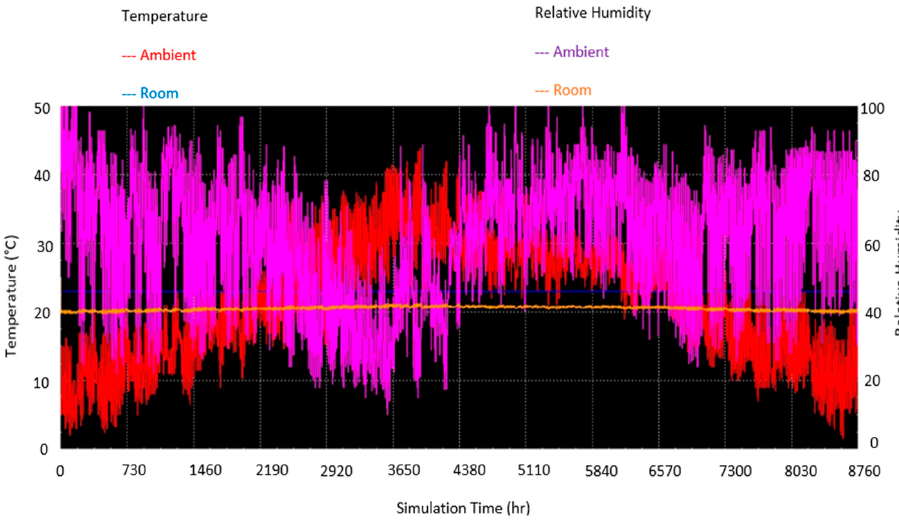
Figure 18. One year simulation run for Option B.